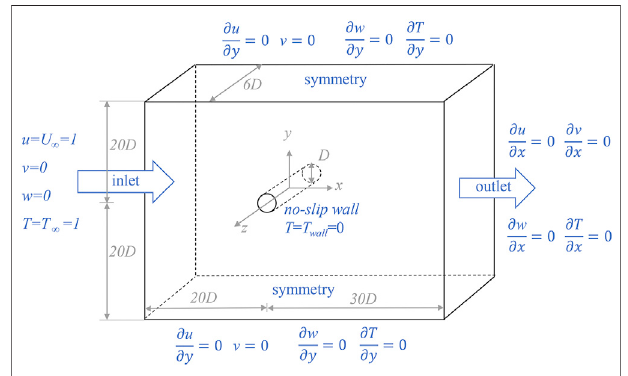
FIGURE 1 | Schematic diagram of the computational domain and corresponding boundary conditions. u , v , and w represent the x -, y -, and z - components of u .